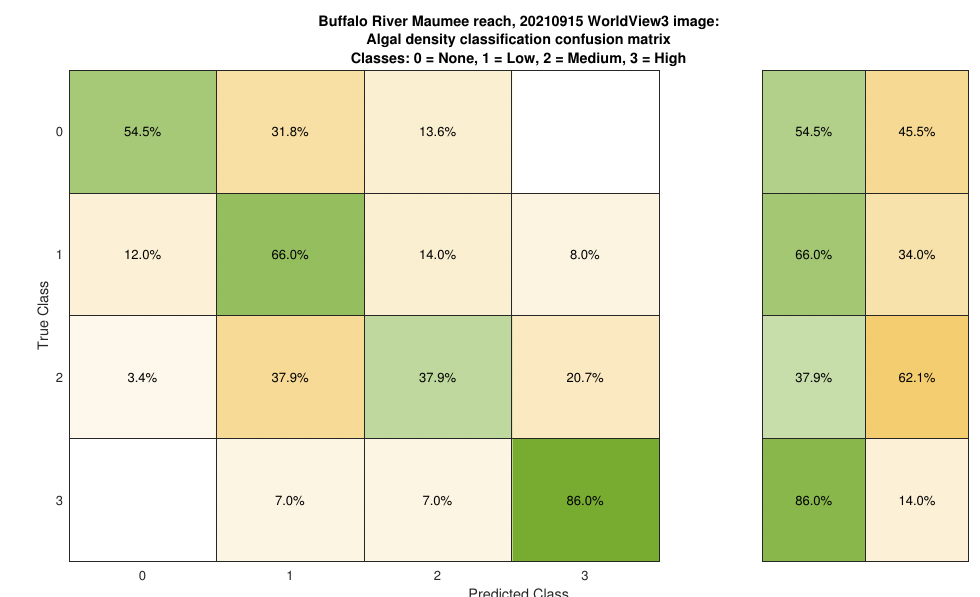
Figure 12. Example confusion matrix for a classification of algal density produced from the 15 September WorldView3 image of the Maumee reach of the Buffalo River. The color scale represents the proportion of pixels in each combination of true class and predicted class, with green tones indicating higher proportions and lighter orange indicating a lower proportion. The smaller array on the right side of the figure lists the producer’s accuracy in the right column and the omission error in the left column.